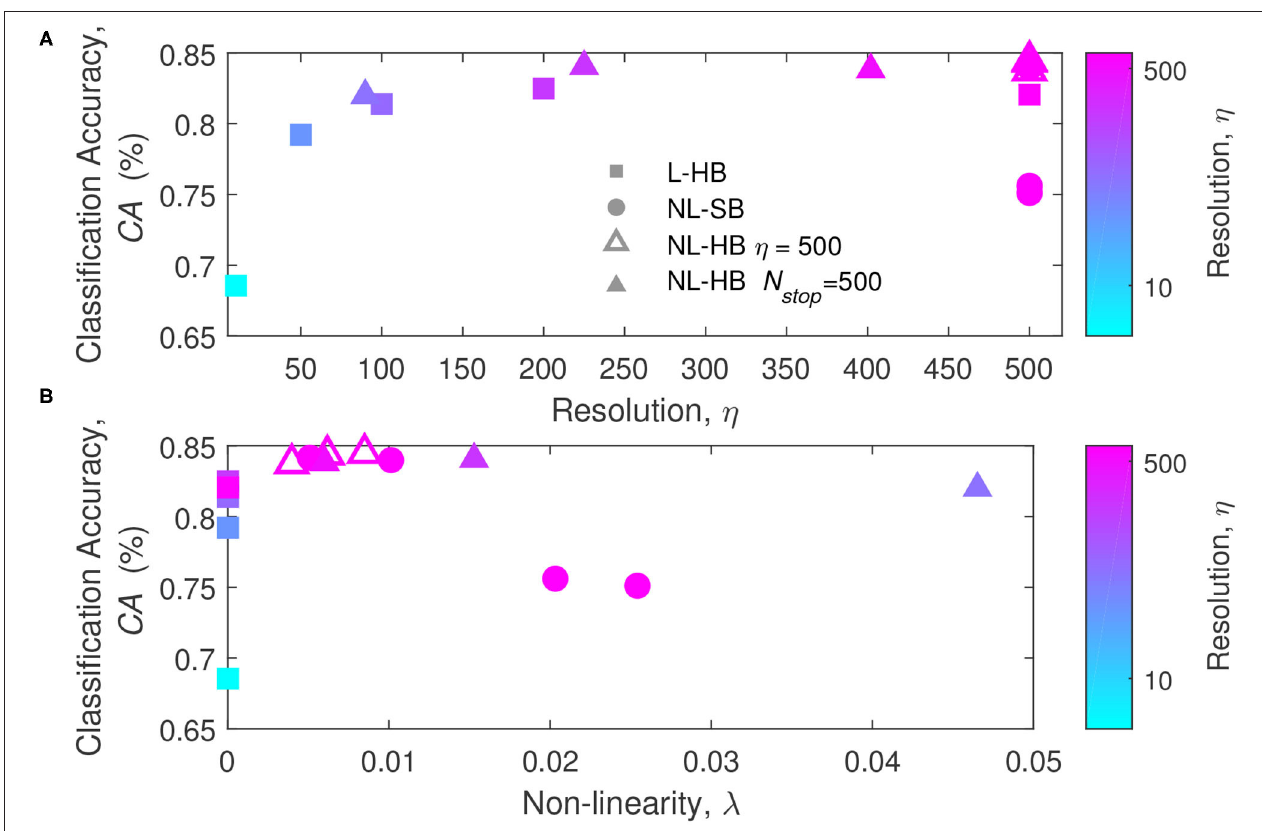
FIGURE 4 | Classification accuracy as a function of the parameters η (A) and λ (B) , for the L-HB, NL-SB, and NL-HB cases. The symbols color follow the resolution value, η , according to the color bars reported on the right sides of the panels.